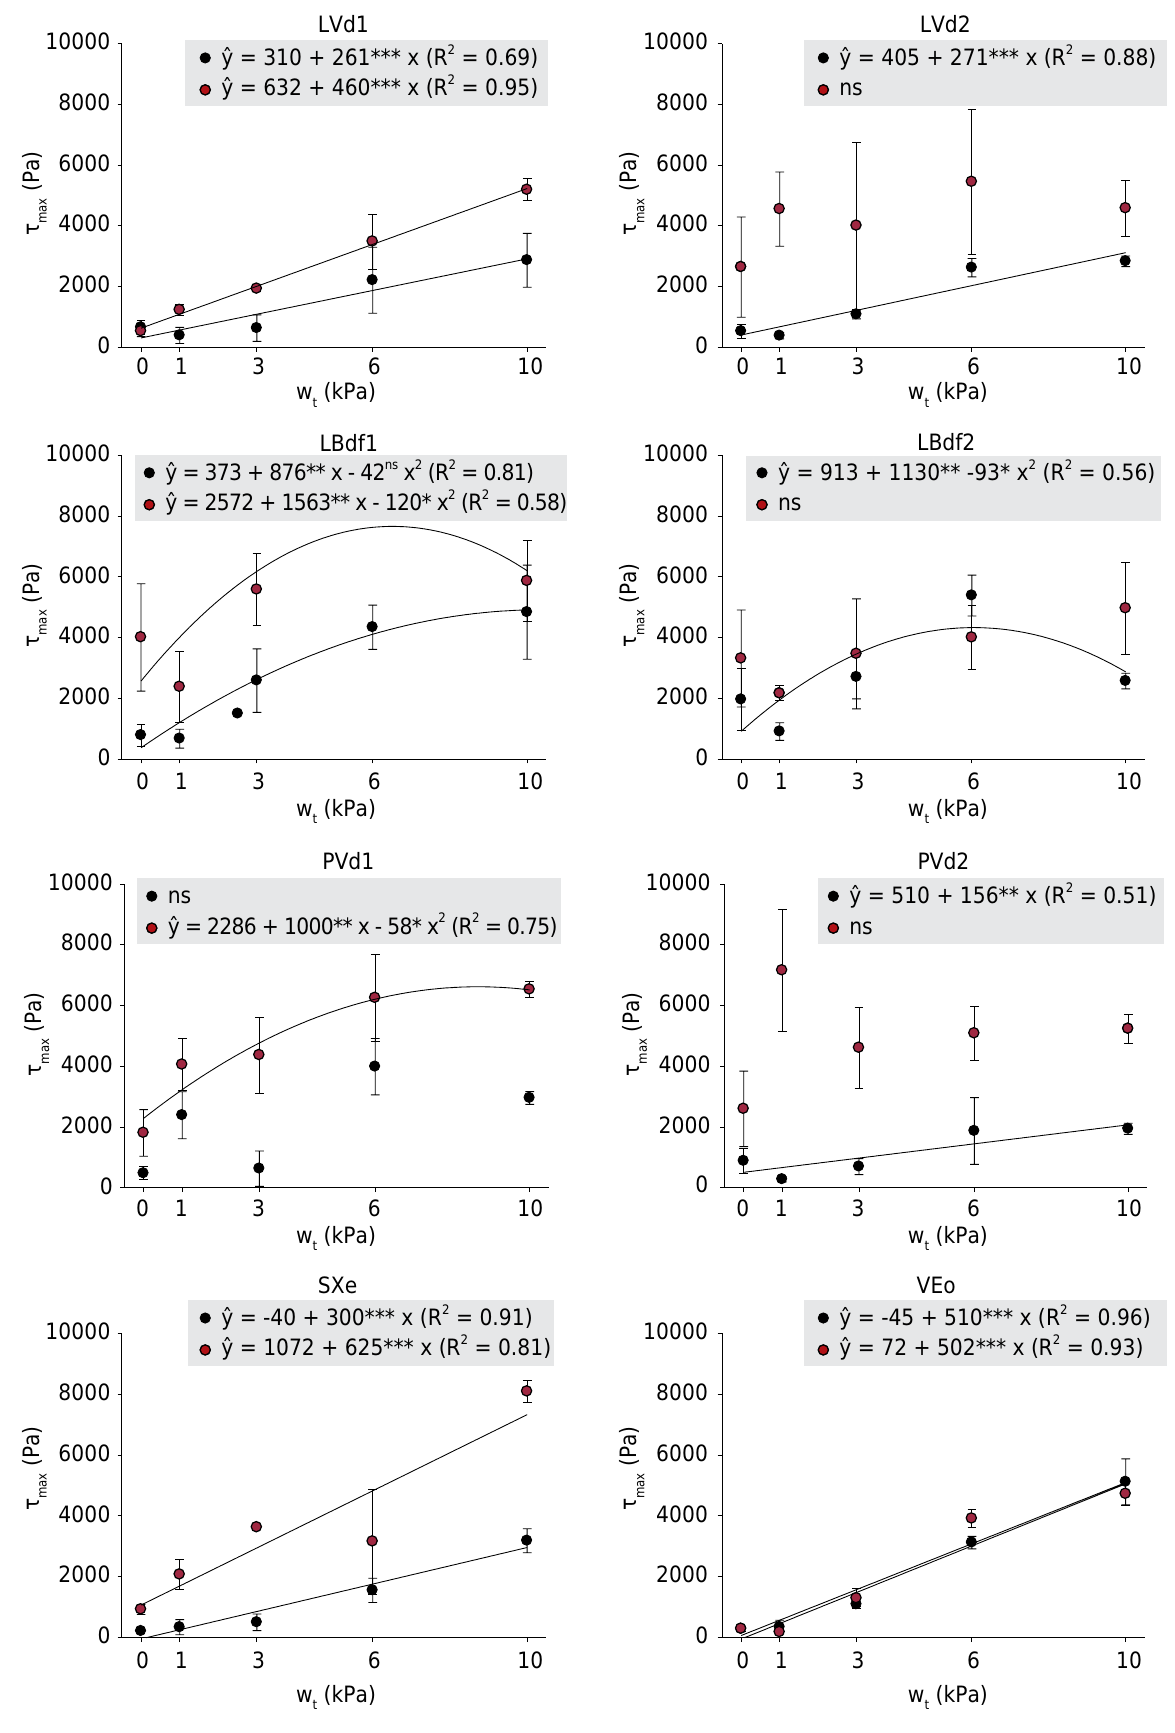
Figure 3. Maximum shear stress (τ max ) as a function of soil water tension (w t ) for A horizons (black symbols) and B horizons (red symbols) of Latossolos /Oxisols (LVd1, LVd2, LBdf1, LBdf2), Argissolos /Ultisols (PVd1, PVd2), Planossolo /Alfisol (SXe), and Vertissolo /Vertisol (VEo). *, ** and ***: significant at 5, 1 and 0.1 %, respectively; ns: not